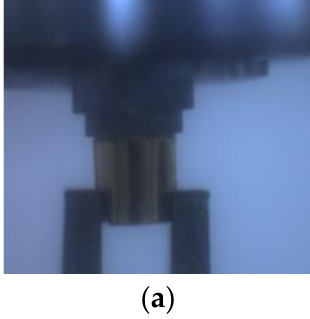
lines to sleeve to mark its left posture.